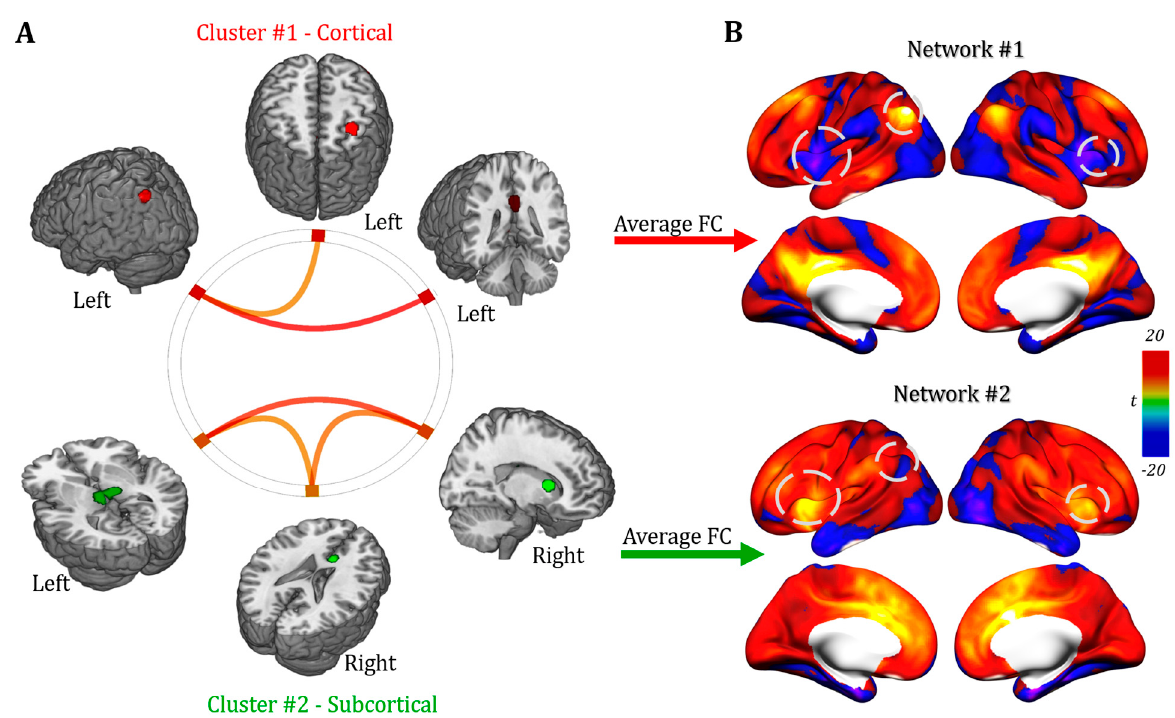
Figure 5. Functional cluster mapping. ( A ) A strong similarity within the functional connectivity profile of cortical regions (Cluster #1, red) and subcortical regions (Cluster #2, green) was highlighted by the functional clustering analysis. ( B ) Resulting average functional connectivity maps characterizing cortical and subcortical clusters (i.e., Networks #1 and #2) show similar topography in the anterior prefrontal cortex but partially negatively correlated profiles in parietal and ventrolateral prefrontal cortices (dashed circles).